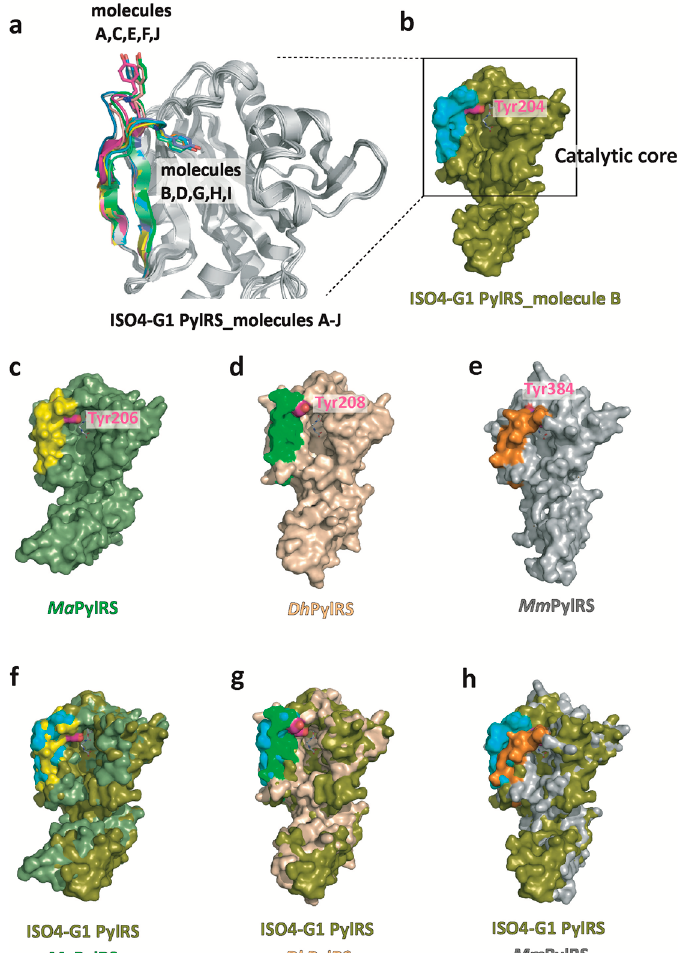
Figure 2. Structural comparisons of ISO4-G1 PylRS with Ma PylRS, Dh PylSc, and Mm PylRSc. ( a ) The β 5- β 6 hairpins in the ISO4-G1 PylRS molecules A, B, C, D, E, F, G, H, I, and J are colored green, cyan, magenta, yellow, vermilion, white, lavender, orange, light green, and turquoise blue, respectively. Tyr204 is shown as stick models. ( b – e ) Surface models of ISO4-G1 PylRS, Ma PylRS (PDB: 6JP2), Dh PylSc (PDB: 2ZNI), and Mm PylRSc (PDB: 2ZIM). ( f – h ) Superimpositions of the crystal structures of ISO4-G1 PylRS, Ma PylRS (PDB: 6JP2), Dh PylSc·tRNA Pyl complex (PDB: 2ZNI), and the pyrrolysyladenylate (Pyl-AMP)-bound Mm PylRSc (PDB: 2ZIM), represented by surface models. The β 5- β 6 hairpins in ISO4-G1 PylRS and Ma PylRS and the β 7- β 8 hairpins in Mm PylRSc are colored cyan, yellow, green, and orange, respectively. The catalytic core structures of ISO4-G1 PylRS, Ma PylRS, Dh PylSc, and Mm PylRSc superimposed well.